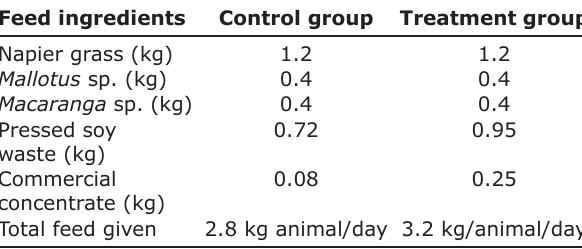
Table-1: Feed formulation for control and treatment